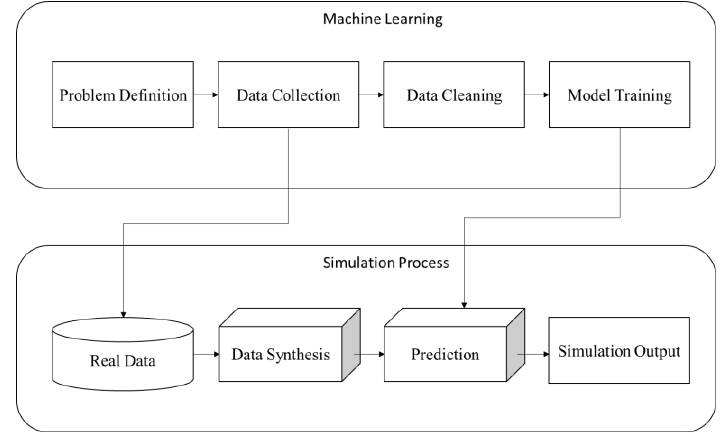
Figure 4. Workflow of Data Twin construction.